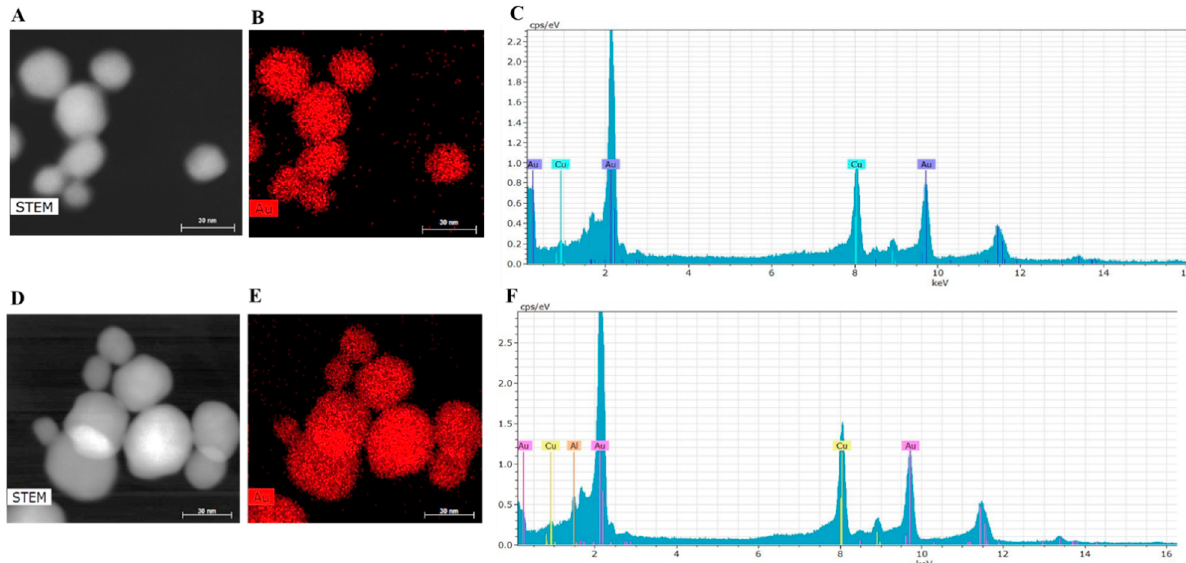
Figure 6. STEM scanning and EDS compositional analysis of gold nanoparticles. ( A ). HAADF STEM micrograph of gold nanoparticles synthesized by pUC19-Vec cells collected after centrifugation at 17,000 × g . ( B ). Color-coded EDS elemental map of the gold nanoparticles. ( C ). EDS spectrum of gold nanoparticles showing the energy peaks of different elements. ( D – F ) show the same analysis used in ( A – C ), but of gold nanoparticles from pUC-Syn recombinant